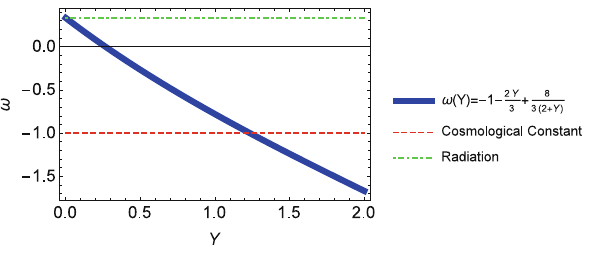
/ a 4 for β = 1 Fig. 2 ω versus Y = α B 2 0 an EoS corresponding to de Sitter spacetime i.e. ω = − 1 −√ 7 , we have (the usual cosmological constant), at Y = 65 4 ω = 0 for non-relativistic matter (baryons, CDM), also